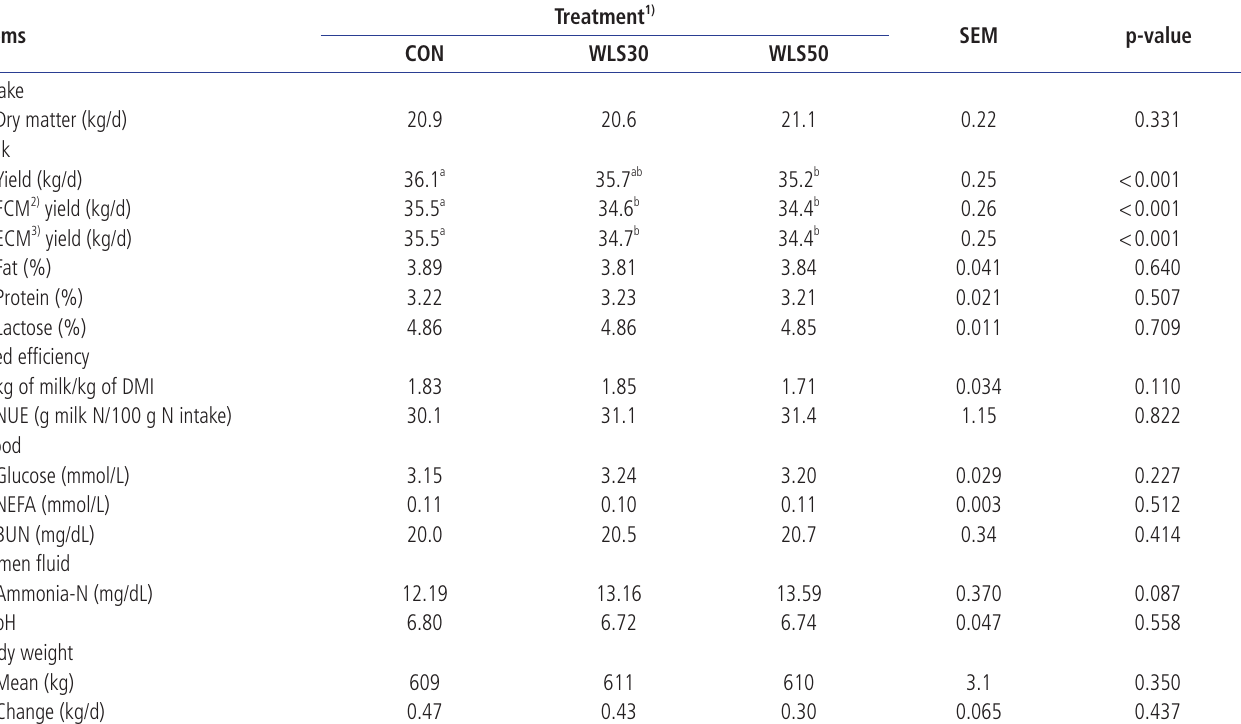
Table 3. Feed intake, milk production and composition, blood plasma metabolites, rumen fermentation parameters, and body weight of cows fed the control diet or diets containing white lupine seeds